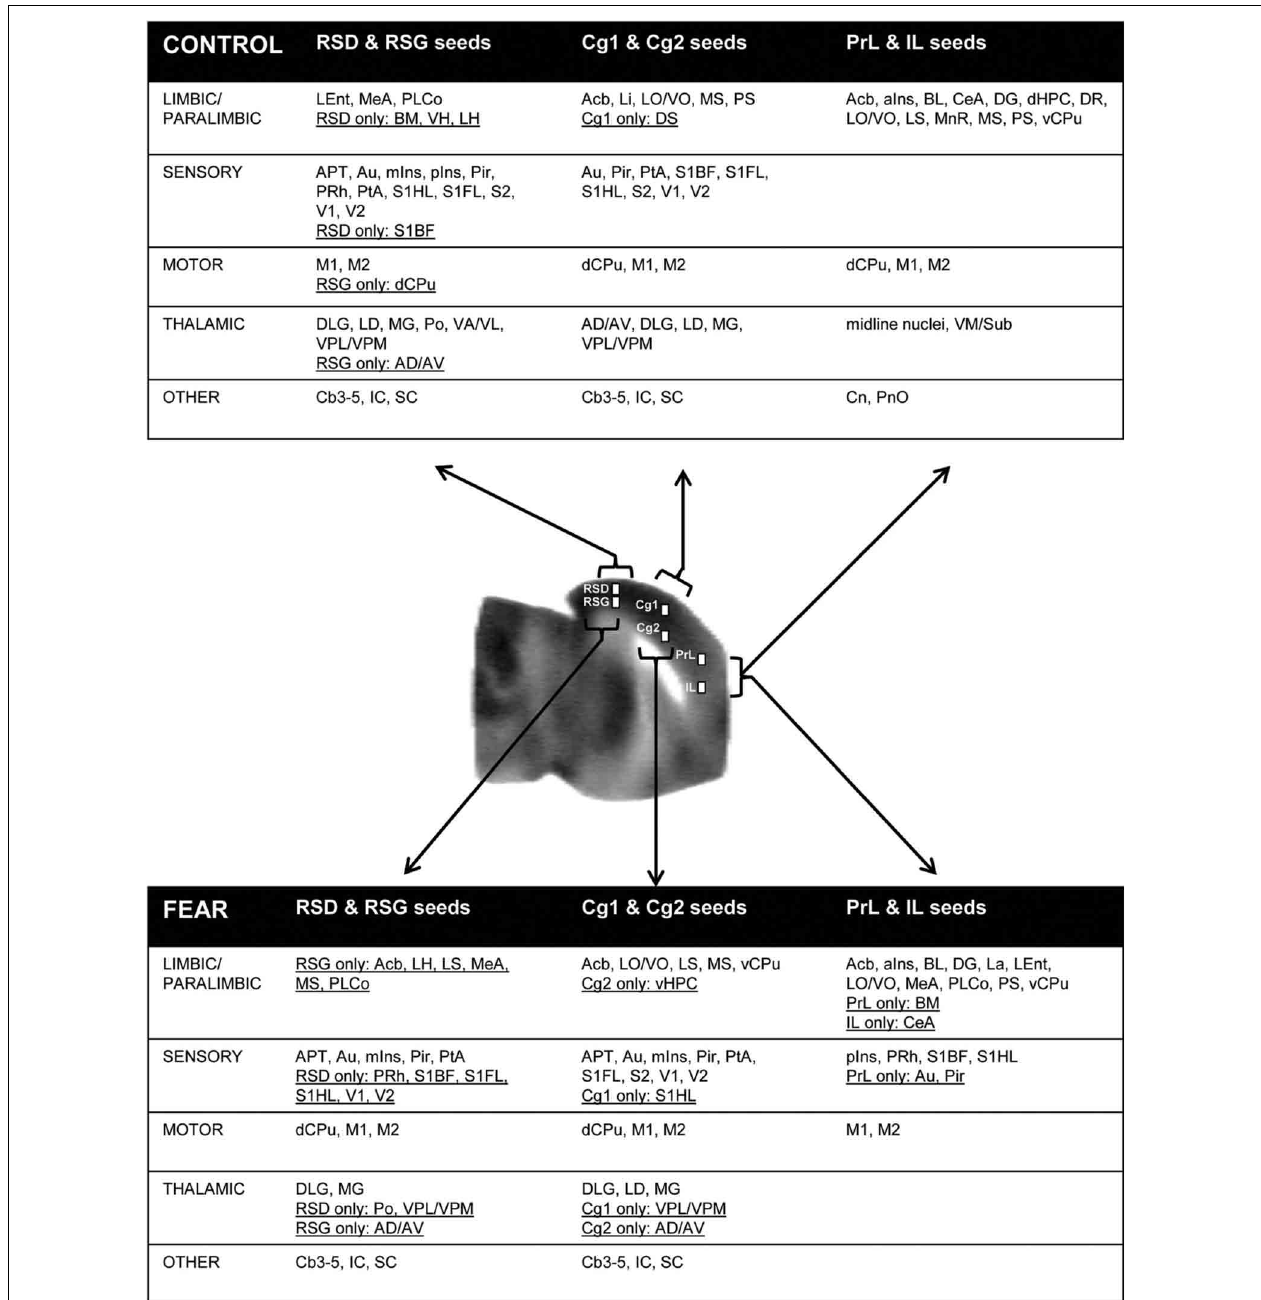
FIGURE 7 | Summary of positive functional connectivity for cortical midline structures with other brain areas. Significant correlations are shown for seeds representing the right prelimbic, infralimbic, cingulate area 1, cingulate area 2, retrosplenial dysgranular and retrosplenial granular cortices. Brain areas that showed correlation to only one seed in each dorsal-ventral pair were underlined. Abbreviations: aIns, anterior insular cortex; APT, anterior pretectal area; Au, auditory cortex; AD/AV, anterior dorsal/ventral thalamic n.; BL, basolateral amygdalar n.; BM, basomedial amygdalar n.; Cb3–5, cerebellar lobules 3–5; CeA, central amygdalar n.; Cn, cuneiform n.; dCPu, dorsal caudate putamen; DG, dentate gyrus; DLG, lateral geniculate, dorsal; DR, dorsal raphe; DS, dorsal subiculum; IC, inferior colliculus; La, lateral amygdalar n.; LD, lateral dorsal thalamic n.; Lent, lateral